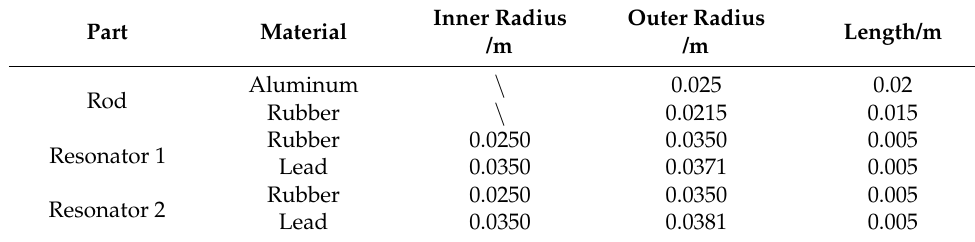
Table 2. Sizes of the components of the coupling